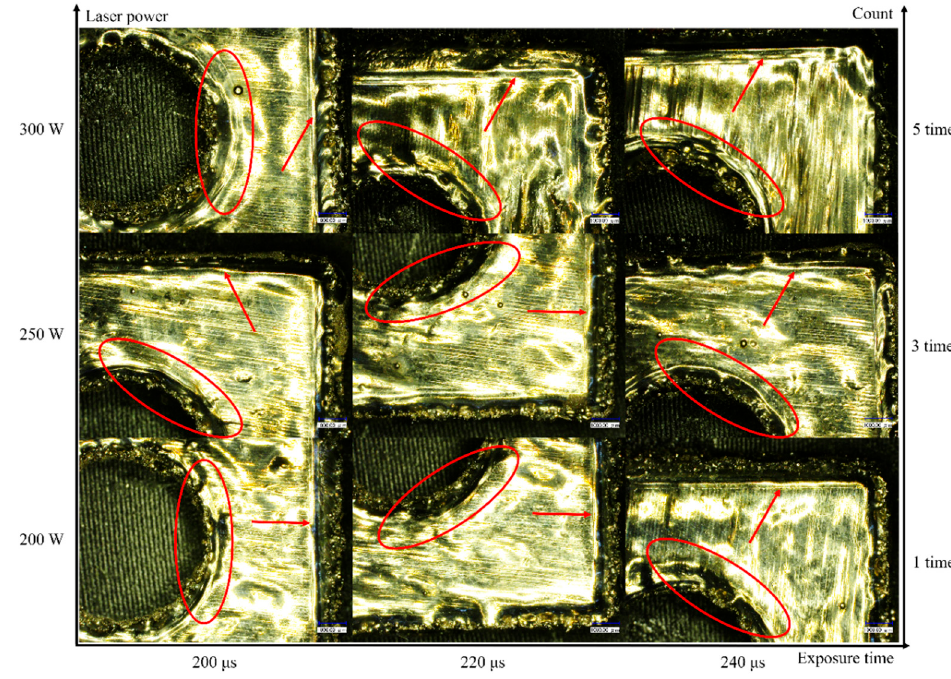
Figure 12. Forming quality with different boundary strategies under 150 μ m layer thickness.